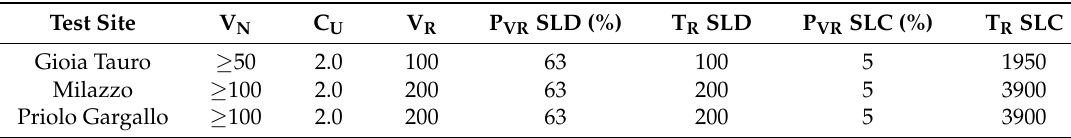
Table 6. Reference period (V R ) associated to the test sites (V R is the product of nominal life V N and coefficient of use C U ), exceedance probability for the limit states considered (P VR SLx), and the related return period T R SLx.